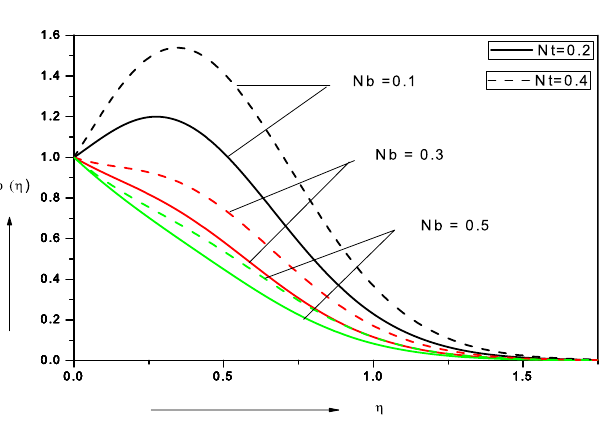
Figure 7. Effect of Brownian motion parameter ( Nb ) on nanoparticle volume